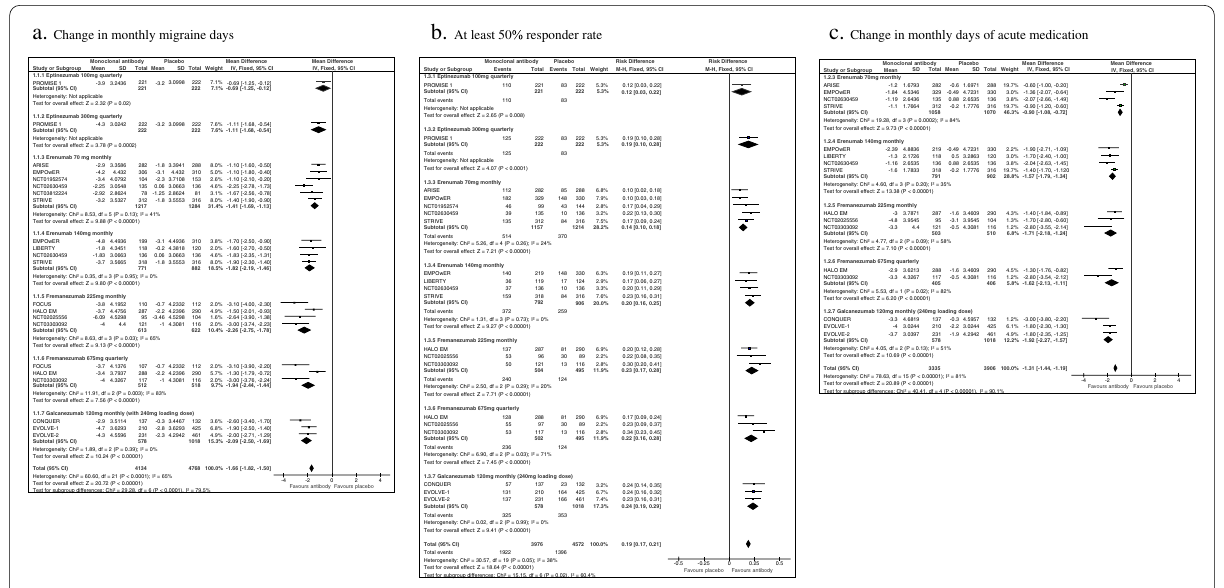
Fig. 3 Forest plots of comparison: 1 Monoclonal antibodies vs placebo ‑ Episodic